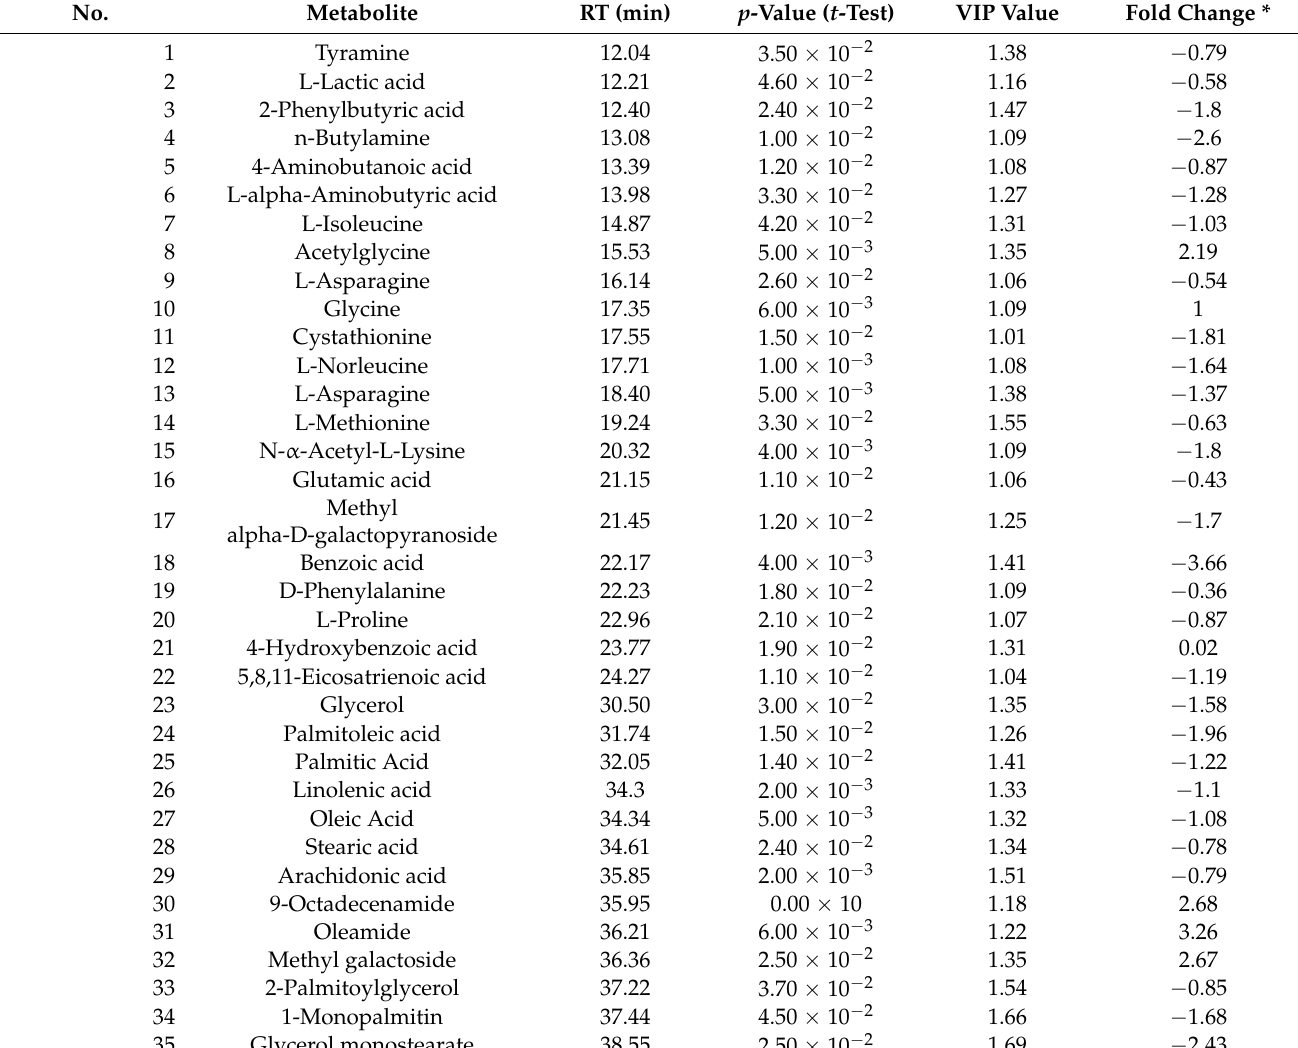
Table 4. Key differential metabolites detected by GC-MS for pectolinarin